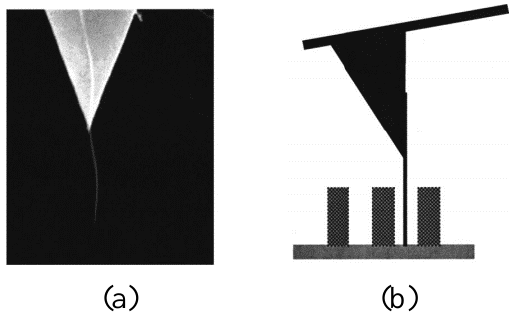
Figure 11. SEM image of a multi-walled CNT (MWCNT) tip and schematic of the CNT tip to trace the profile of trenches. ( a ) SEM image of a CNT scanning probe, ( b ) the ability of the CNT tip to trace the profile of trenches with deep and narrow features. Adapted with permission from [51], Copyright AIP Publishing LLC,